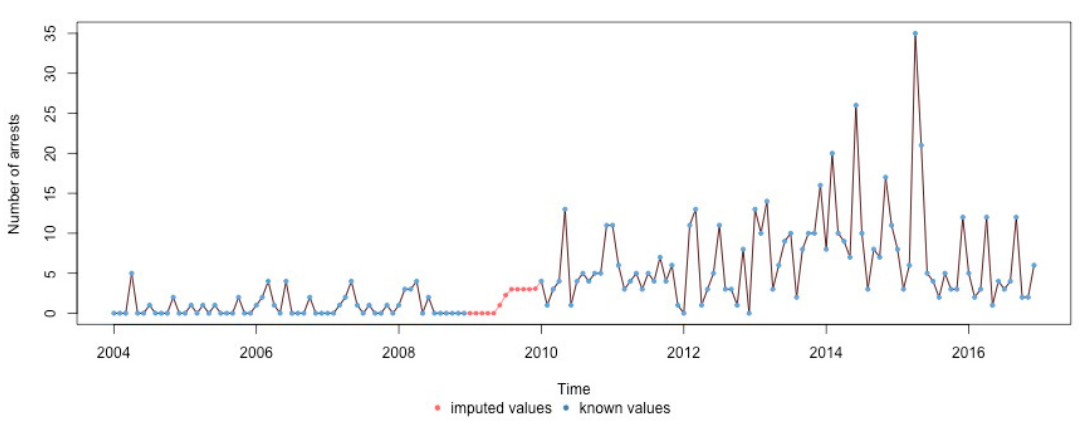
Figure A4. Methamphetamine Vietnamese nationals arrests 2004–2016 in the Czech Republic—imputed missing values.